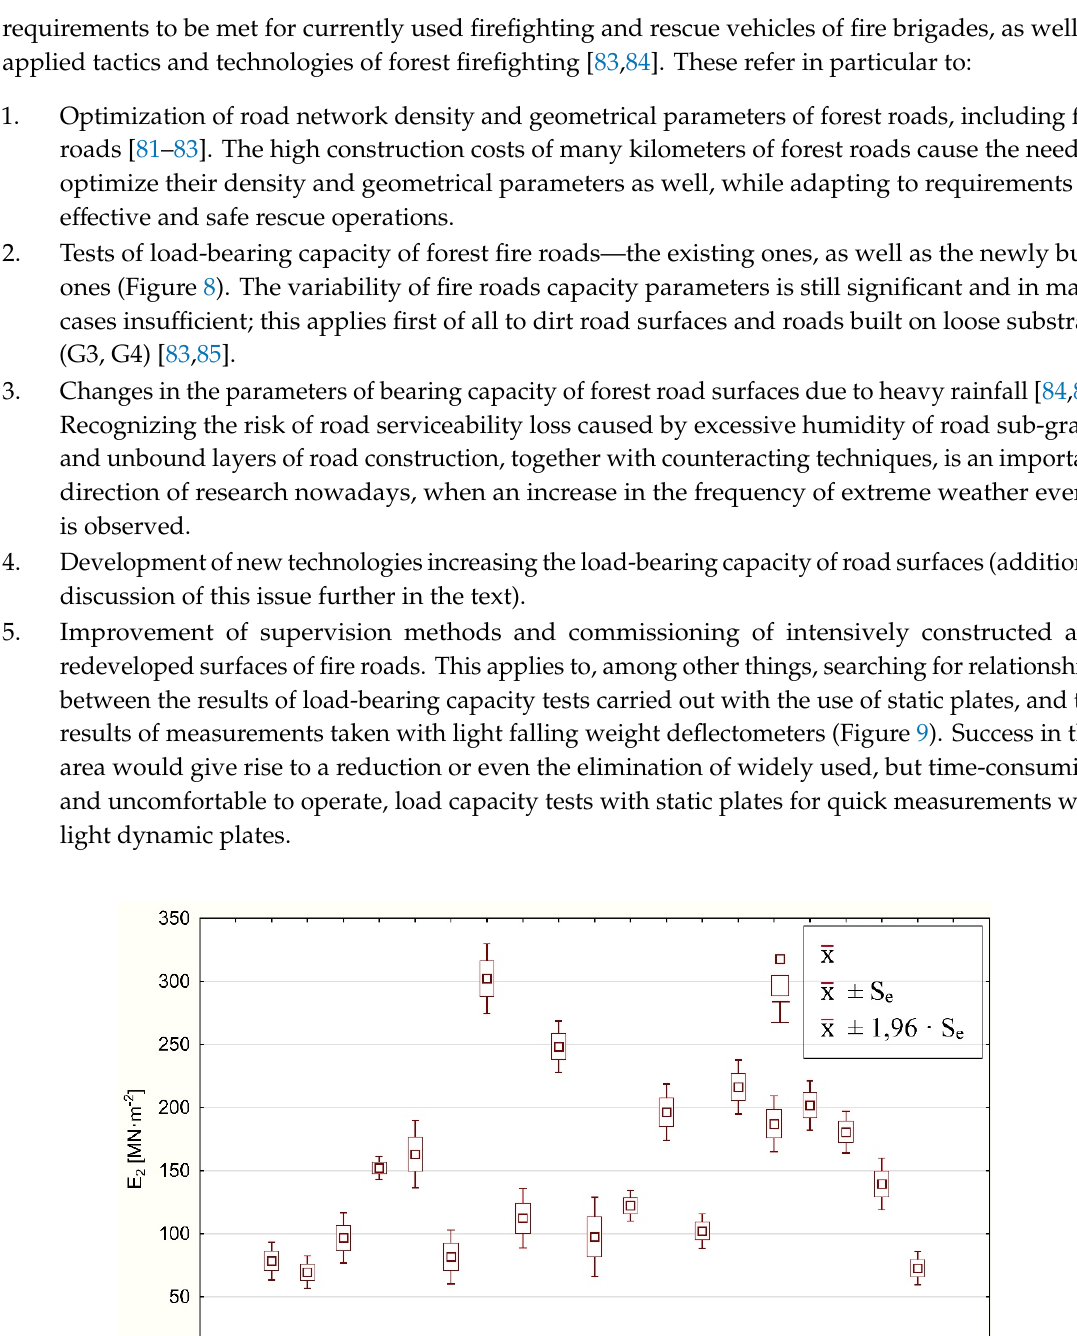
Figure 8. Statistical characteristics of constrained modulus during secondary compression (E2) according to groups of surfaces in fire roads (GNN: ungraded dirt road; GNP: graded dirt road; GU: improved dirt road surface; Po/ Ż : gravelly sand or gravel surfaces; Ż u ż : slag surfaces (blast furnace slag); Rec: surfaces of recycled aggregates (concrete debris, construction rubble, brick debris, rail subgrade crusher ‐ run materials); Mopt: optimal dirt mix surfaces; T ł ucz: crushed ‐ stone aggregate road surfaces; McA: macadam surfaces; T/GeoR: aggregate surfaces on geogrid; GeoK: geogrid surfaces; Emul: asphalt surfaced aggregate pavements; 1 ‐ war: single ‐ layer surfaces; 2 ‐ war: 2 ‐ layer surfaces; 3 ‐ war: min. 3 ‐ layer surfaces; G1, G2, G3, G4: fire with G1, G2, G3 and G4 subgrades [83].